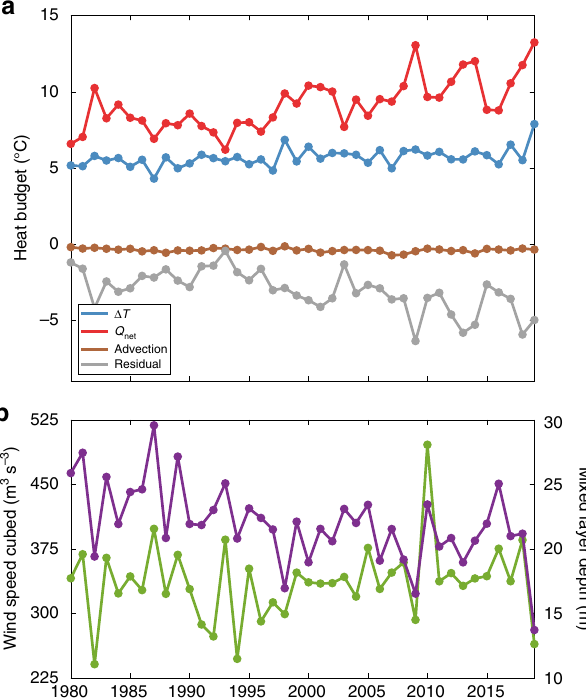
Fig. 3 Mixed layer heat budget estimated in ocean reanalysis. a August minus May temperature change (°C; blue) and the respective budget terms contributing to this change. Budget terms include total surface heat fl ux (red), horizontal advection (brown), and entrainment/residual (gray). b June – August (JJA)-averaged reanalysis wind speed cubed (green/left y - axis; m 3 s − 3 ) and mixed layer depth (purple/right y -axis; m) area-weighted averaged in black box seen in Fig. 1a. All time series are for the time period 1980 –